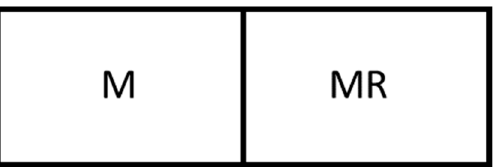
Figure 10. The optimum 2-mod design that maximizes the size of the AOS. In this case, this design can achieve a 65% larger space than the base case membrane reactor.